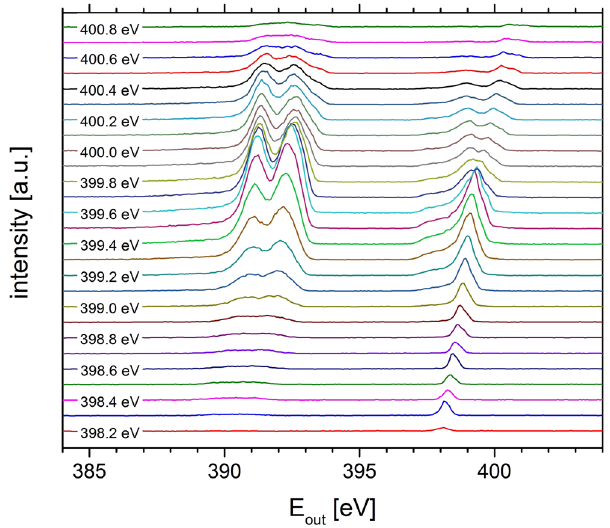
Figure 3. Emission lines of acetonitrile at different excitation energies extracted from the RIXS-map shown in Fig.